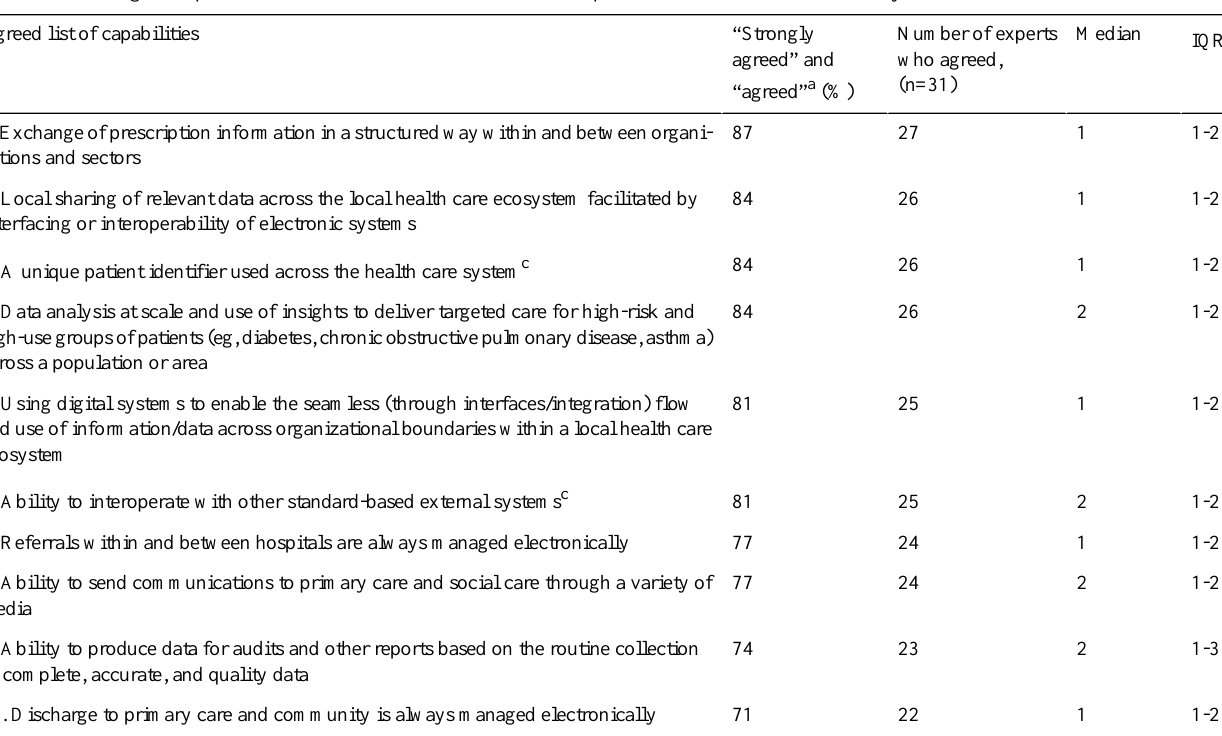
Table 3. Technological capabilities related to communication with other parts of the health and social care system.